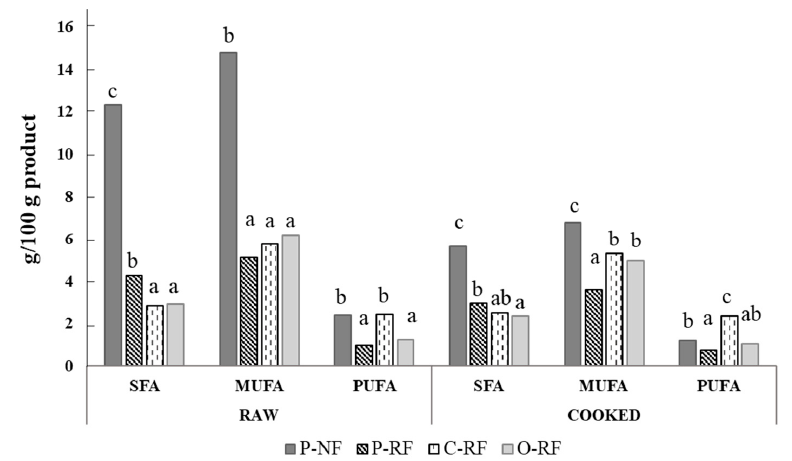
Figure 2. Saturated fatty acid (SFA), monounsaturated fatty acid (MUFA) and polyunsaturated fatty acid (PUFA) (g / 100 g of product) of raw and grilled cooked longanizas. For samples denominations, see Figure 1. Different letters (a, b, c), for the same type of fatty acid (SFA, MUFA or PUFA) and treatment of samples (raw or cooked), indicate significant differences ( p < 0.05) between different formulations (P-NF, P-RF, C-RF and O-RF).